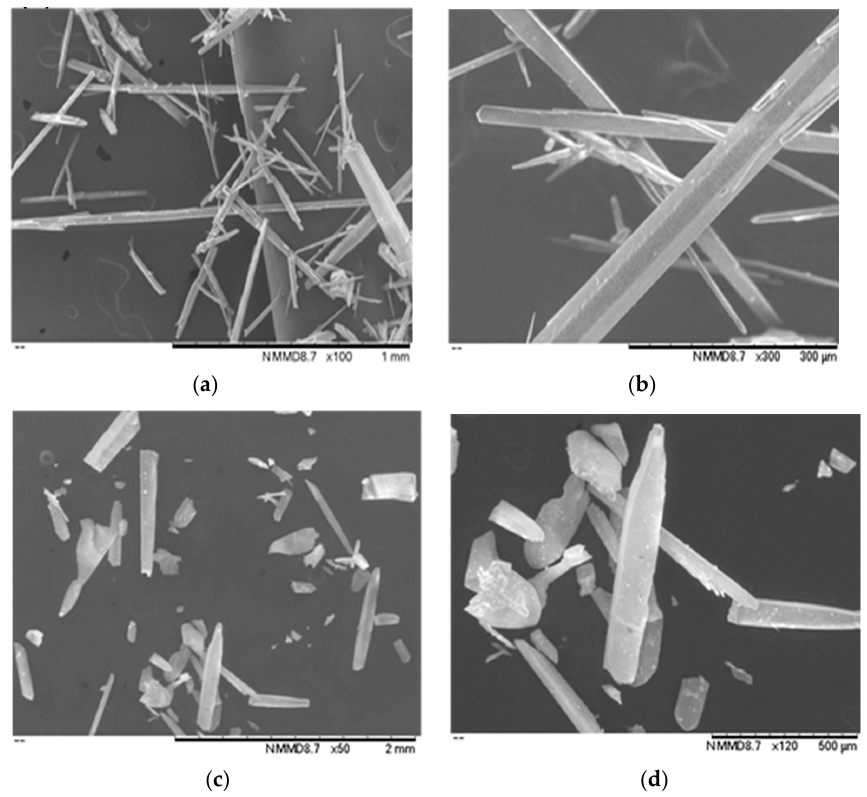
Figure 4. Micrographies (SEM) of the crystals after recrystallization with methanol of DADB ( a ) 100× and ( b ) 300×, and DEADP ( c ) 50× and ( d ) 300×.